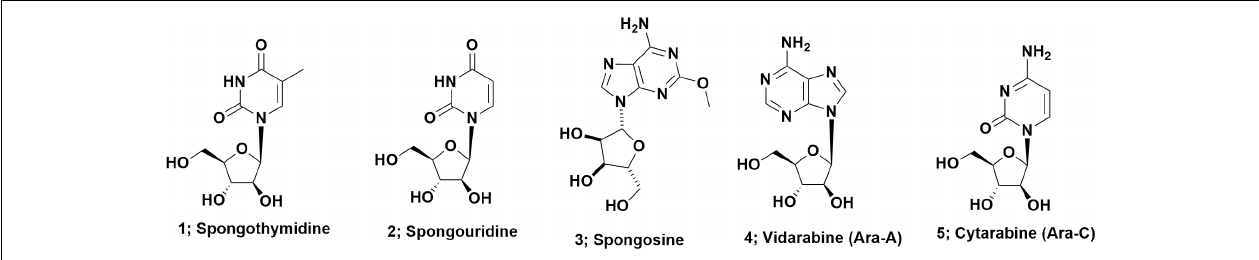
FIGURE 1 | Nucleoside derivatives from marine